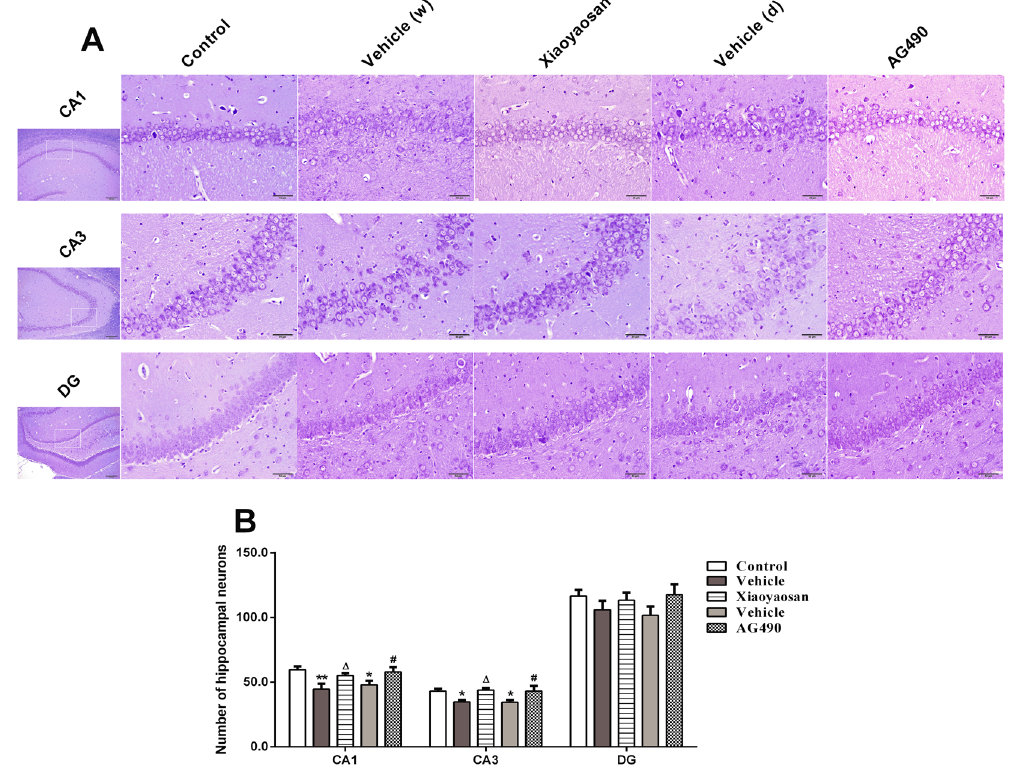
Figure 2. The effects of Xiaoyaosan on hippocampal neurons were measured using Cresyl violet staining. ( A ) Representative micrographs of the CA1, CA3 and DG regions of the hippocampus. The first row of micrographs was captured at low magnification under a light microscope (scale bar = 200 μ m, 100 × magnification); the remaining micrographs were captured at higher magnification under a light microscope (scale bar = 50 μ m, 400 × magnification). ( B ) Quantitative analysis of the numbers of Cresyl violet-stained neurons in the hippocampal CA1, CA3 and DG regions. Values are presented as the means ± SEM from 5 rats in each group. * P < 0.05 or ** P < 0.01 versus the control group. Δ P < 0.05 versus the vehicle (distilled water) group. # P < 0.05 versus the vehicle (dissolvent)